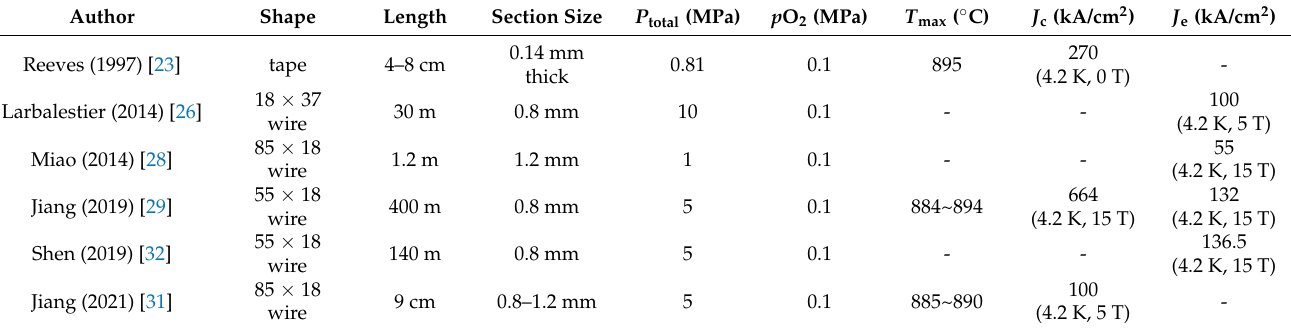
Table 2. Parameters of Bi-2212 wires fabricated using the overpressure